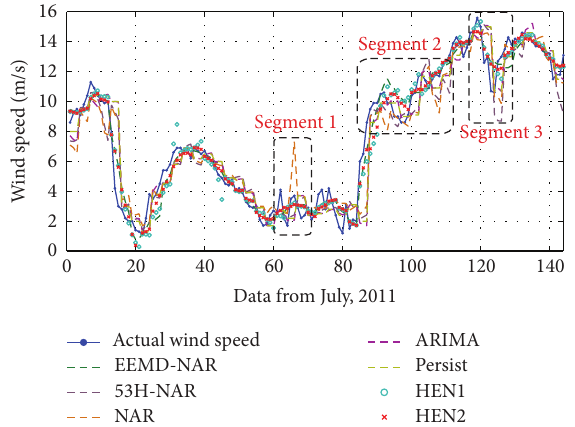
Figure 9: Forecasting results from different models, exampled by data at Station 1 from July 2011.